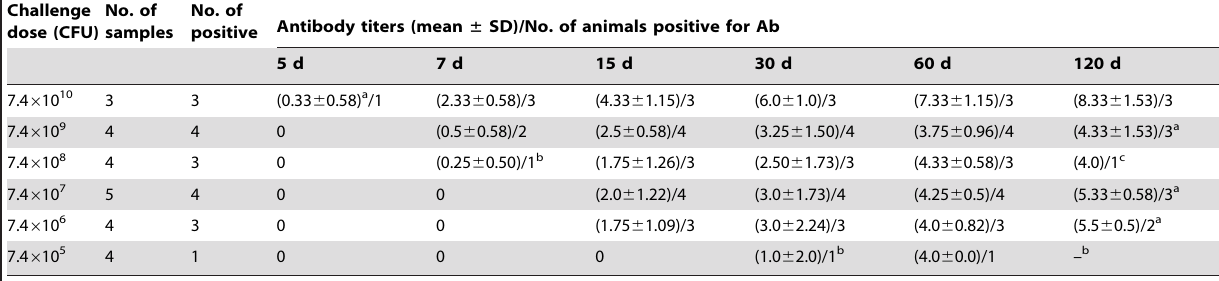
No. of No. of Challenge dose (CFU) samples positive Antibody titers (mean ± SD)/No. of animals positive for